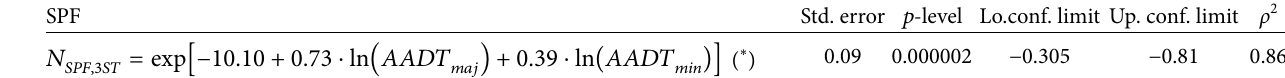
Table 4: Overview of the calibrated 𝑁 HSM functions without re-adjusting the coefficients to local